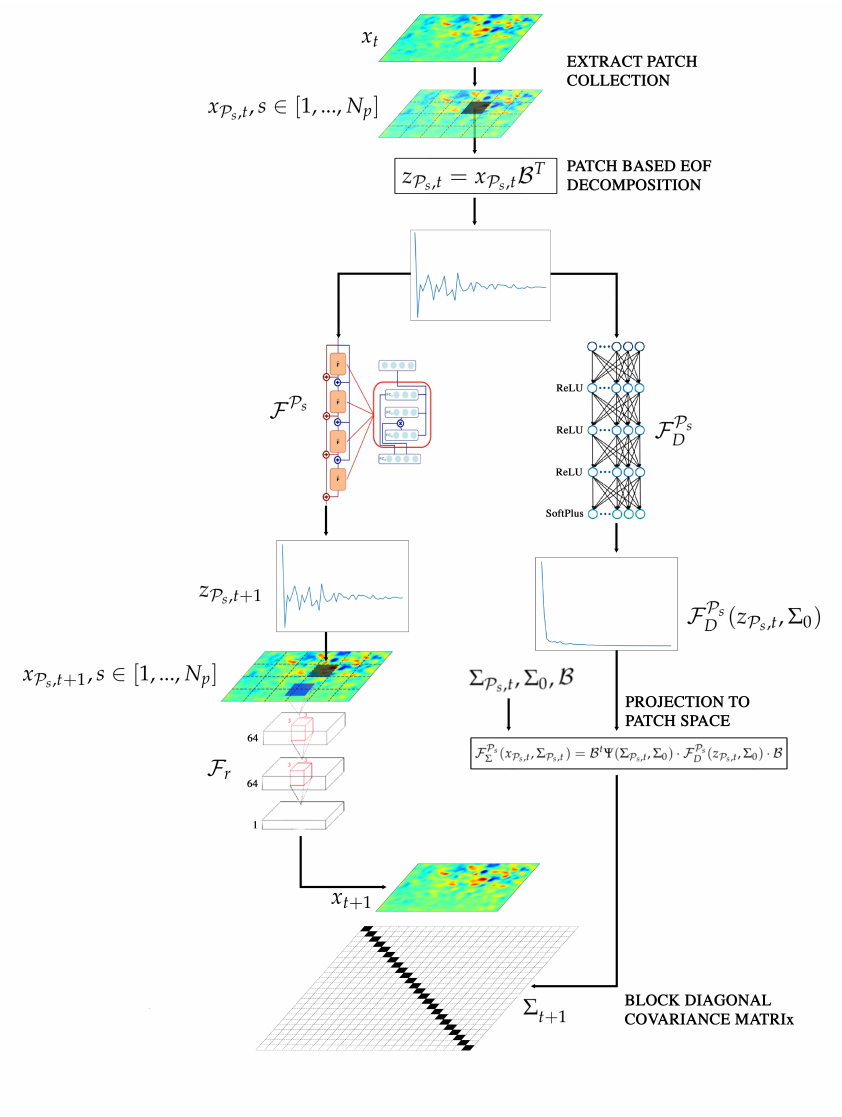
Figure 1. Proposed neural-network-based representation of a spatio-temporal dynamical system. The input X t is first decomposed into P × P patches, each patch is then propagated using its